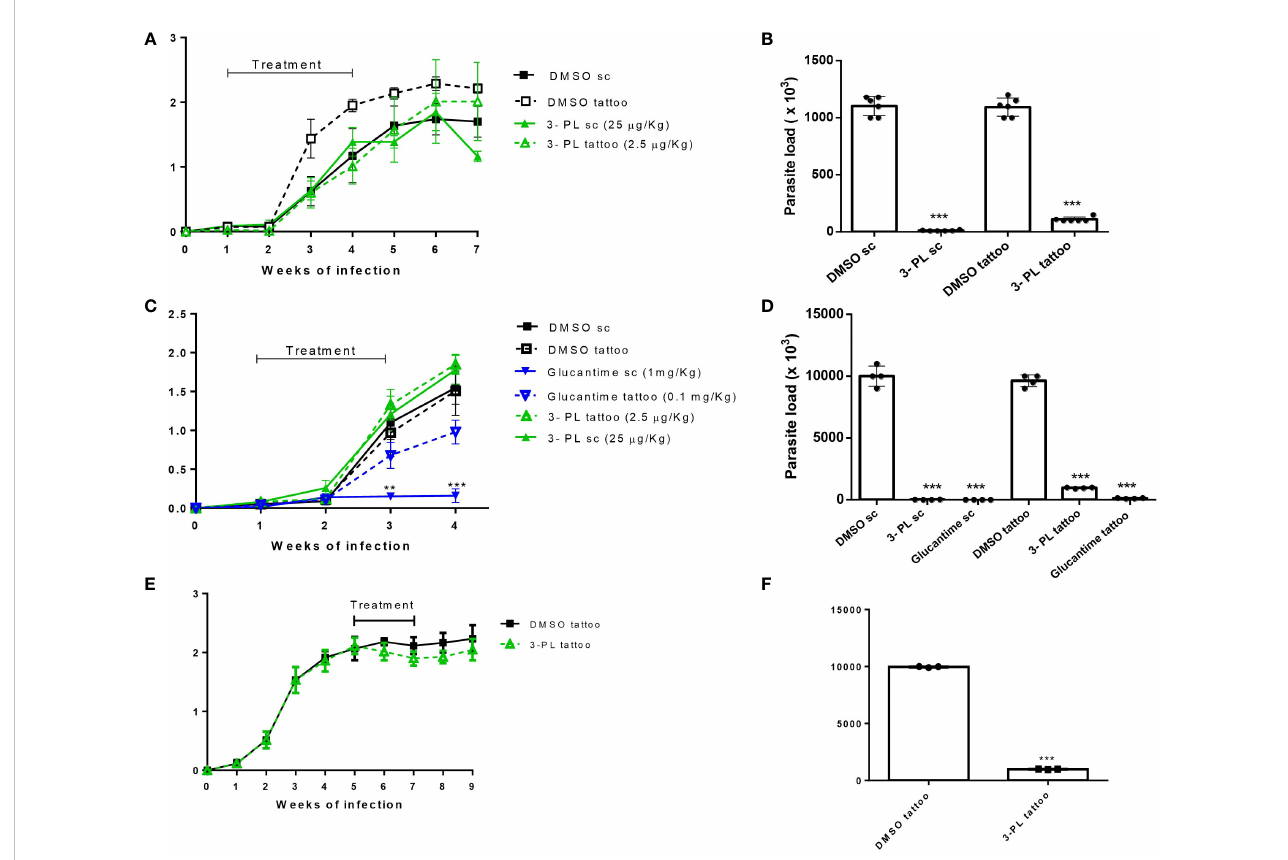
FIGURE 4 Therapeutic activity of 3-PL administered subcutaneously or tattooing in hamsters infected with L. ( V. ) braziliensis. Hamsters golden (3-6/group) were infected with 10 6 promastigotes of L. ( V. ) braziliensis in the dorsal hind paw and treated from 7 days (A-D) or from 5 weeks after infection (E,F) with vehicle DMSO 0.5% in PBS (DMSO sc or DMSO tattoo); 3-PL by subcutaneous (3-PL sc, 25 µg/Kg) or tattooing (3-PL tattoo, 2.5 µg/Kg); Glucantime ® subcutaneous (Glucantime ® sc, 1mg/Kg or tattooing (Glucantime ® tattoo, 0.1 mg/Kg) routes. (A) Treatment during 3 weeks (3 times/week= 9 doses). (C, E) Treatment during 2 weeks (2 times/week= 4 doses). Lesion thickness (A, C, E) , expressed as the difference between the thickness of the infected and uninfected paws, were presented as means ± SD, and parasite load in skin paw was determined in the fi nal experiment by limiting dilution analysis (B, D, F) ; n=4-6; **p < 0.01 and ***p < 0.001 in relation to respective DMSO control (sc or tattoo